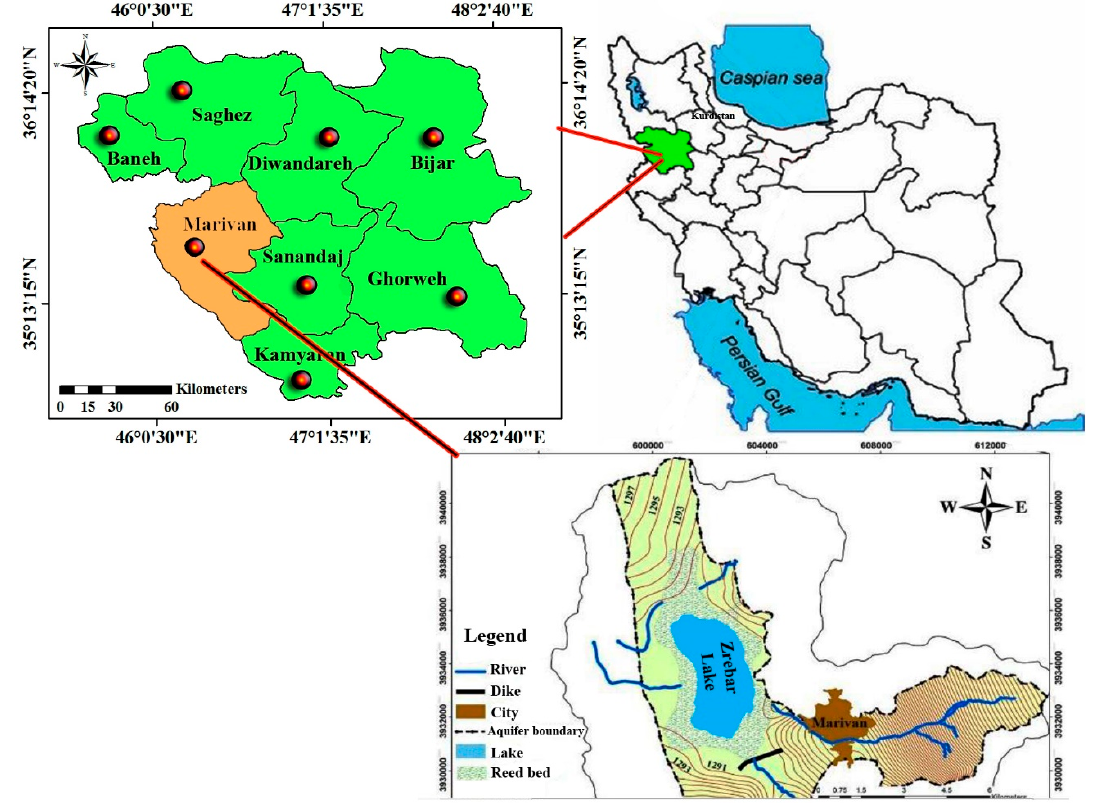
Figure 1. Location of the study area [53].